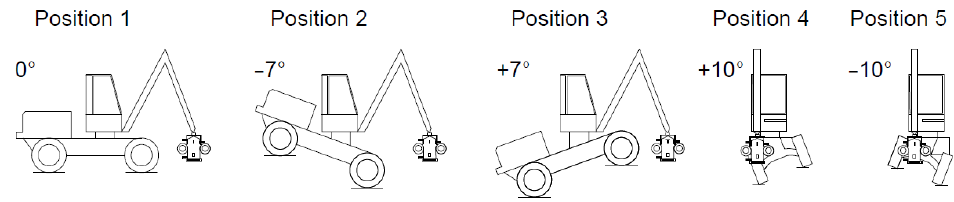
Figure 4. Figures of schemes following the same